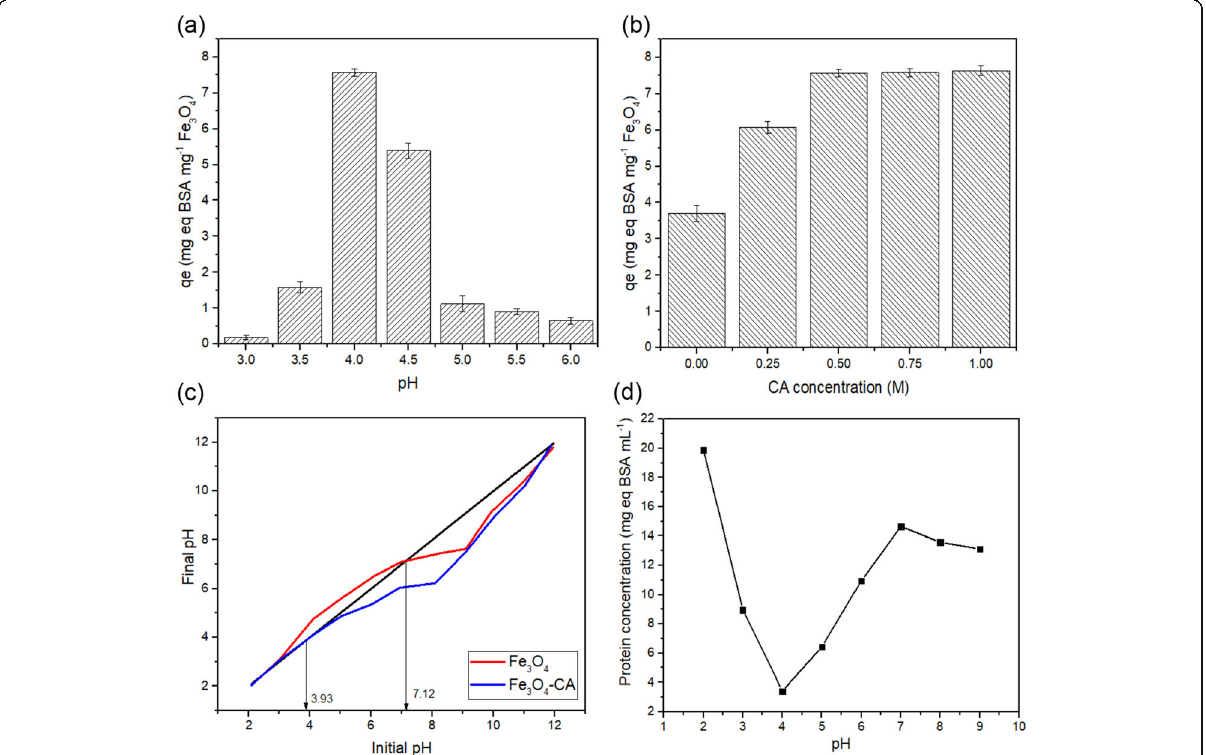
Fig. 1 The profile of protein adsorption capacity at various pH (trisodium citrate concentration 0.5 M) ( a ), various trisodium citrate concentration (protein adsorption at pH 4.0) ( b ), point of zero charge of Fe 3 O 4 and Fe 3 O 4 -CA (trisodium citrate concentration 0.5 M) ( c ), and pI of leucaena protein ( d